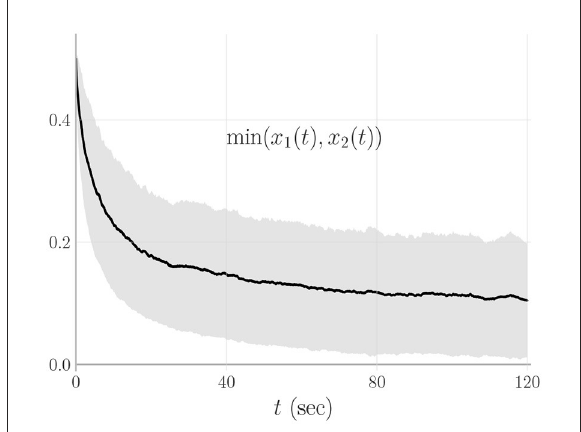
FIGURE1 Mean (black) and standard deviation (light gray) curves of one thousand sample